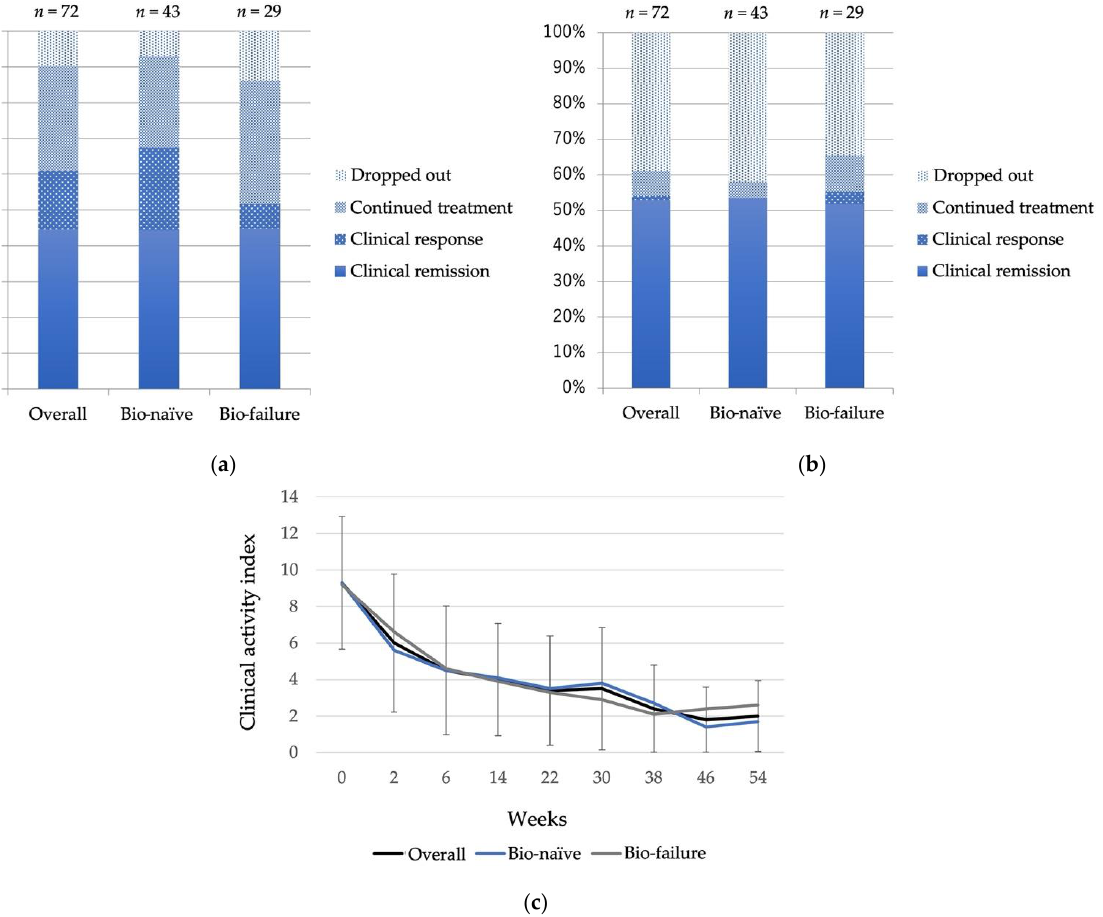
Figure 1. Clinical outcomes of patients treated with Vedolizumab ( a ) at week 6 and ( b ) at week 52. ( c ) Changes of clinical activity index. Treatment efficacy was assessed using the Lichtiger clinical activity index.